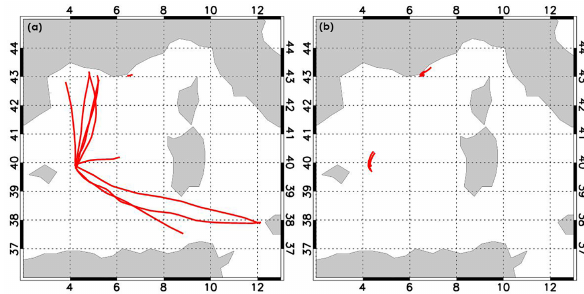
Figure 3. Trajectories of the flights for the 10 BLPBs (a) and 17LDBs (b) .